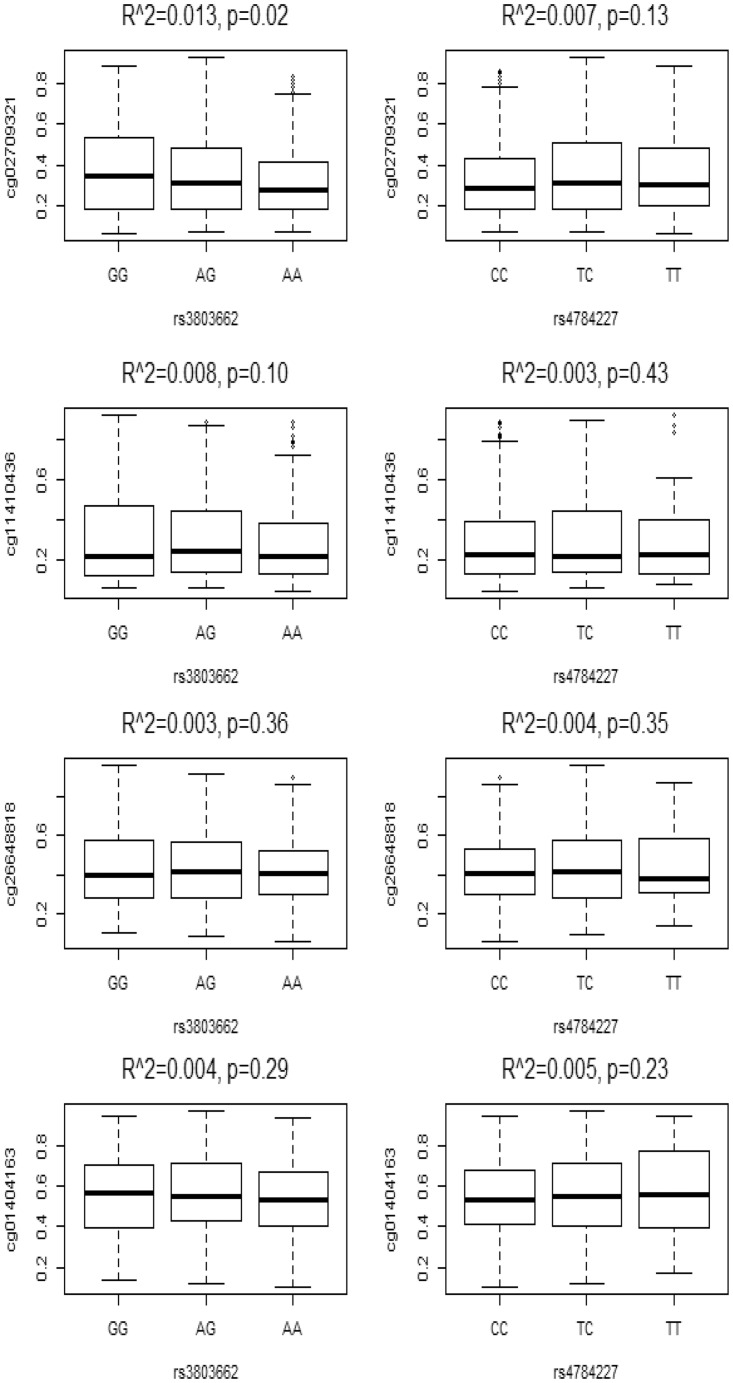
mQTL analyses between SNP genotypes and CpG site methylation of the TOX3 promoter.Linear regression model applied to mQTL analysis. Y-axis represents CpG sites (cg02709321, cg11410436, cg26648818, and cg01404163) and X-axis shows SNP variants (rs3803662 and rs4784227). R squared and p values shown on the top.